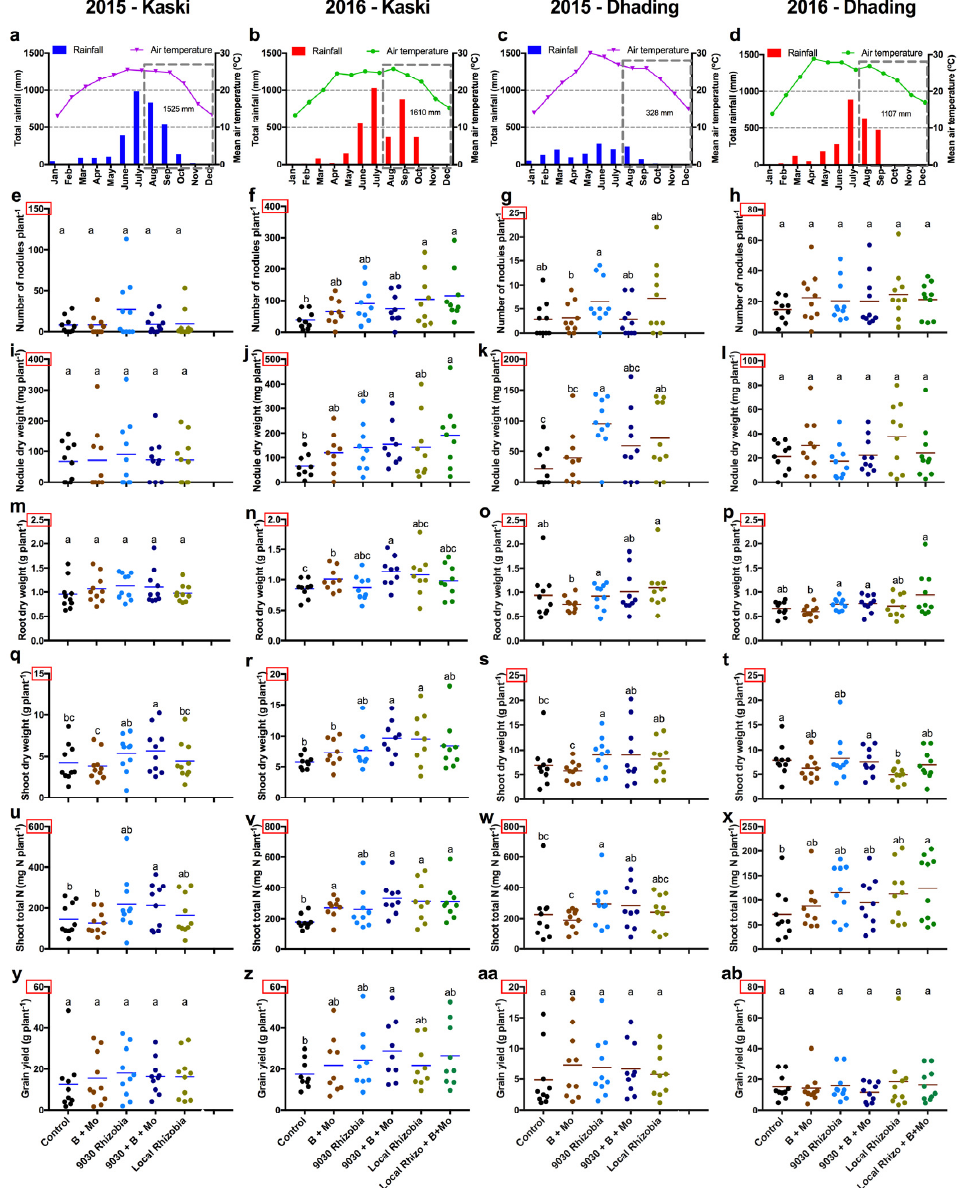
Figure 2. Meteorological and agronomic data collected at the Dhading and Kaski sites in 2015 and 2016. ( a – d ) Average monthly temperature and total monthly precipitation at ( a ) Kaski-2015, ( b ) Kaski-2016, ( c ) Dhading-2015, and ( d ) Dhading-2016. For (a–d), the dotted box represents the common bean growing season; the rainfall amount noted is the accumulated rainfall during the growing season. ( e – h ) Number of nodules at ( e ) Kaski-2015, ( f ) Kaski-2016, ( g ) Dhading-2015, and ( h ) Dhading-2016. ( i – l ) Nodule dry weight at ( i ) Kaski-2015, ( j ) Kaski-2016, ( k ) Dhading-2015, and ( l ) Dhading-2016. ( m – p ) Root dry weight at ( m ) Kaski-2015, ( n ) Kaski-2016, ( o ) Dhading-2015, and ( p ) Dhading-2016. ( q – t ) Shoot dry weight at ( q ) Kaski-2015, ( r ) Kaski-2016, ( s ) Dhading-2015, and ( t ) Dhading-2016. ( u – x ) Shoot total nitrogen content at ( u ) Kaski-2015, ( v ) Kaski-2016, ( w ) Dhading-2015, and ( x ) Dhading-2016. ( y – ab ) Grain yield at ( y ) Kaski-2015, ( z ) Kaski-2016, ( aa ) Dhading-2015, and ( ab ) Dhading-2016. Each dot represents an individual farm, while horizontal solid lines represent the mean value of each treatment. Dots followed by the same letter grouping are not significantly different at p < 0.05. n = 10 (except n = 9 at Kaski-2016). Please note that the y-axis scales vary, as indicated by the red boxes.